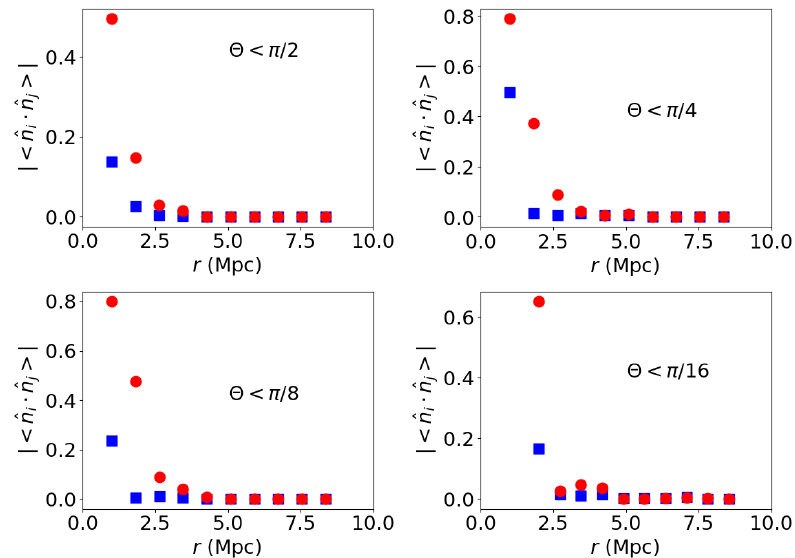
Figure 11. Toy simulations of a galaxy plane—galaxy plane correlation as function of the correlation distance. From top to bottom, the polar angle cut is tightened around the filament axis, so that the cone included features less random galaxies (but always the random ones along the filament). Blue squares: just the random galaxies. Red circles: the filament is now posited to thread perfectly oriented galaxies spaced at 1 Mpc, which are added to the sample from which the correlation is